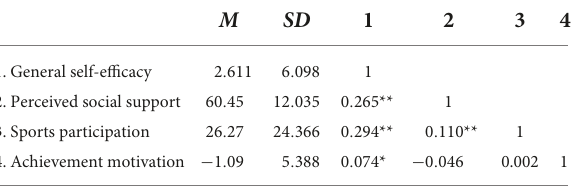
TABLE 3 Descriptive statistics and correlation coefficient of each